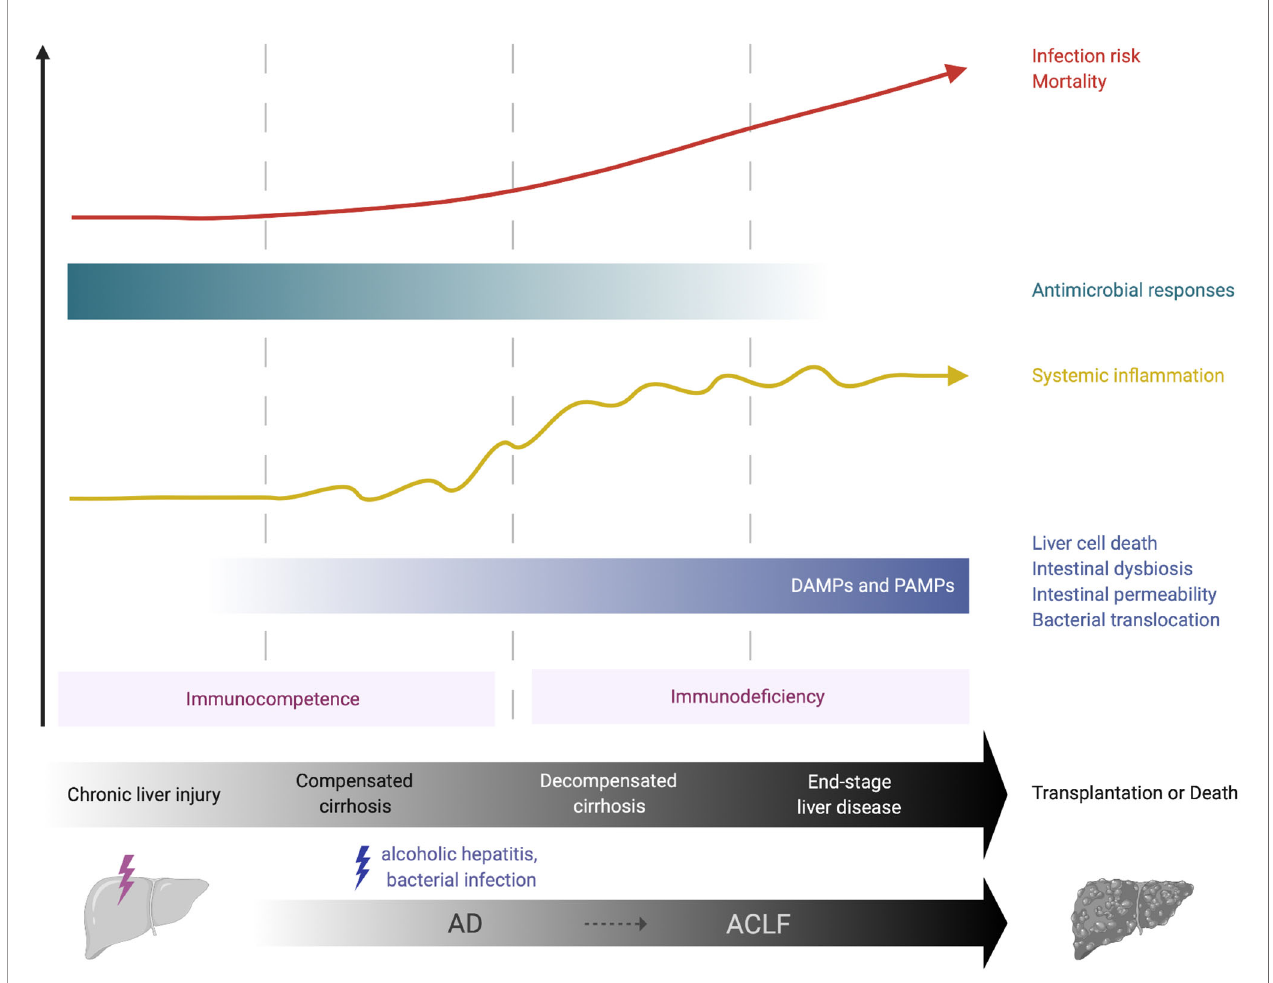
FIGURE 1 | Immunological features of chronic liver failure. Over the course of compensated or decompensated cirrhosis, an acute precipitating event such as alcoholic hepatitis or bacterial infection may challenge liver homeostasis and lead to acute-on-chronic liver failure (ACLF). In compensated cirrhosis, liver-derived DAMPs, for example from necrotic hepatocytes, may activate the local immune system and initiate systemic in fl ammation. In decompensated cirrhosis, increasing alterations in intestinal homeostasis (e.g., bacterial overgrowth, increased permeability) allow the pathological translocation of bacteria, bacterial products (e.g., LPS) and PAMPs into the liver, thus providing further chronic stimulation of innate immune cells and propagation of local and systemic in fl ammation. This may be crucial in the transition from the immunocompetent state (pro-in fl ammatory immune response) to a more hyporesponsive, immunode fi cient state that is observed in advanced cirrhosis. The latter increases the risk of life-threatening infections and substantially contributes to the high morbidity and mortality observed in these patients. ACLF, acute-on-chronic liver failure; AD, acute decompensation; DAMP, damage-associated molecular pattern; PAMP, pathogen-associated molecular